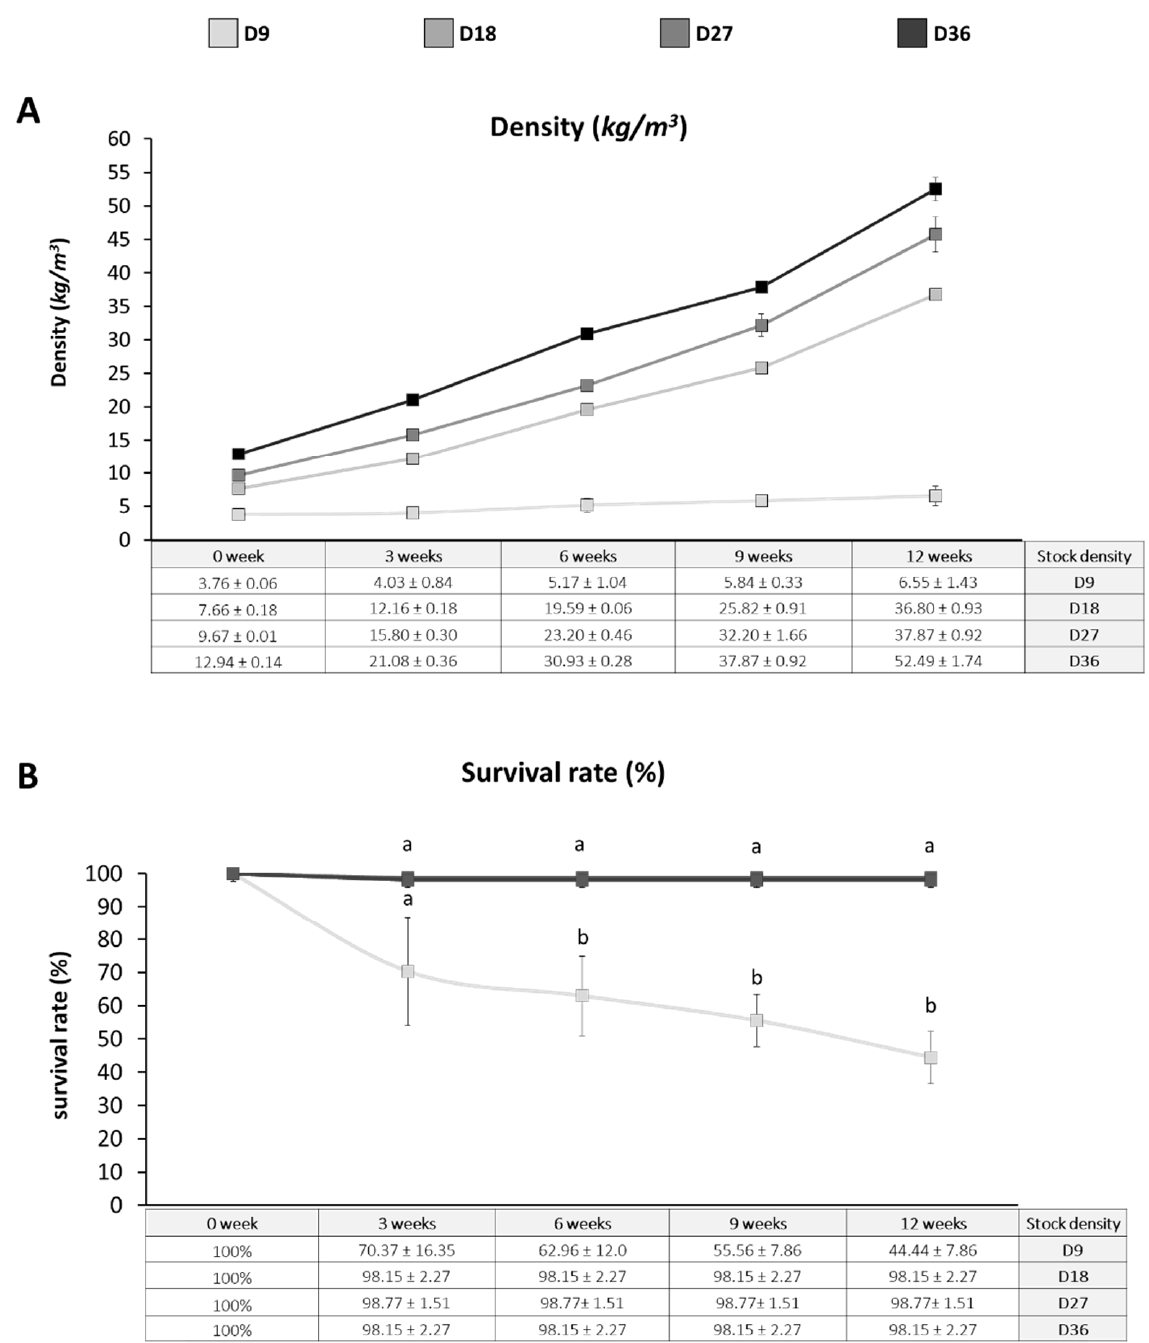
Figure 1. Density ( A ) and Survival rate ( B ) of rainbow trout hand-fed during 12 weeks with different stocking densities. ( A ) Density for each stocking density (D9, D18, D27, D36) is expressed in kg/m 3 at each experimental timing period. ( B ) Fish survival is expressed as % ± S.E.M of survivors in relation to the initial number of fish in each tank, at each experimental timing period. Results are expressed in % of distribution as mean ± S.E.M ( n = 3 tanks). One-way ANOVA, Tukey post hoc followed by a post hoc Tukey’s test in case of significant differences ( p < 0.05, indicated with different letters. Mean values that do no share a common letter are significantly different).